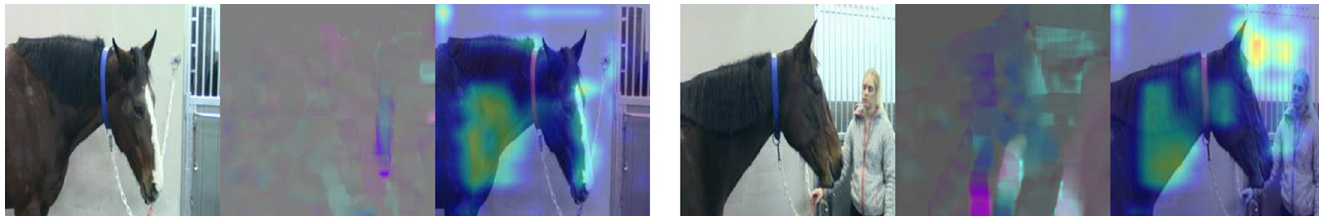
Fig 3. The figures can be viewed as animations in the Supporting information. Here, only the middle frame of each sequence is shown. RGB, optical flow, and Grad-CAM [62] saliency maps of the C-LSTM-2-PF † predictions on clips 10 and 24 (Table 2). Clip 10 ( left ) is a correct prediction of pain. Clip 24 ( right ) is a failure case, showing an incorrect pain prediction, and we observe that the model partly focuses on the human bystander. The remaining 23 clips with saliency maps can be found in the Appendix of S1